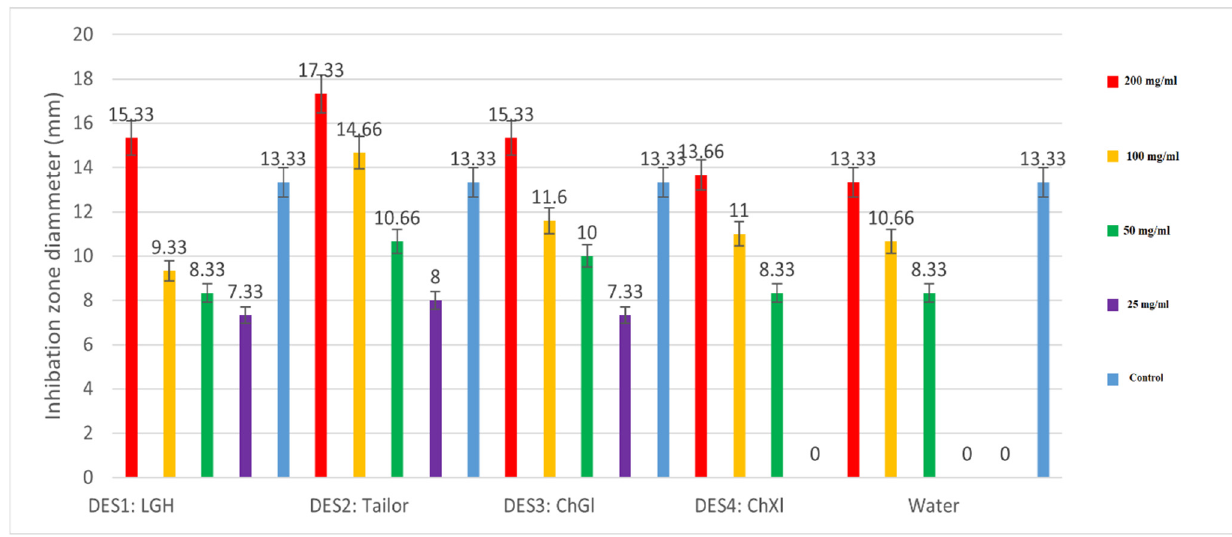
Figure 1. Results of DIZ assay for various DESs plants extracts. The values were presented as the mean ± SD performed in triplicate. mean ± SD performed in